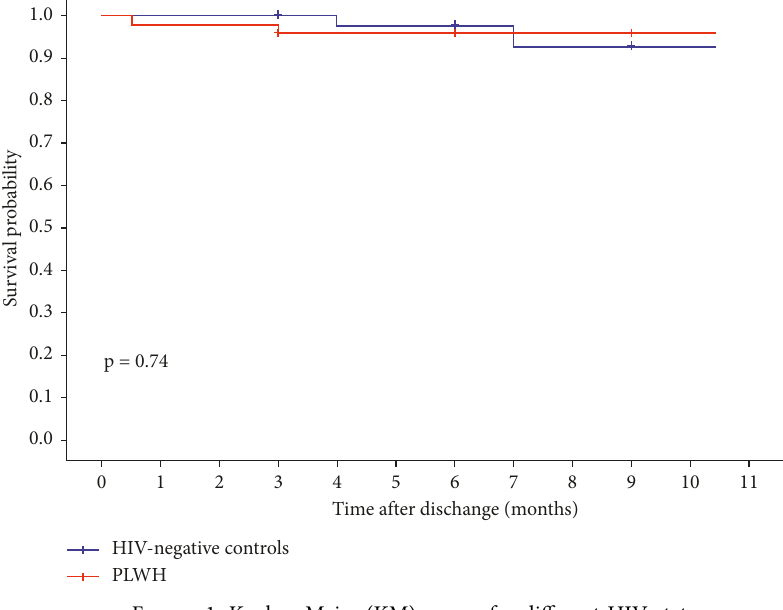
Figure 1: Kaplan–Meier (KM) curves for different HIV